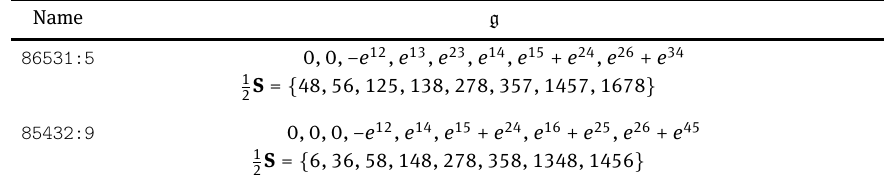
Table 3: 8-dimensional nice nilpotent Lie algebras that satisfy ( K ), ( H ), ( L ) and ( P ) for k = 0